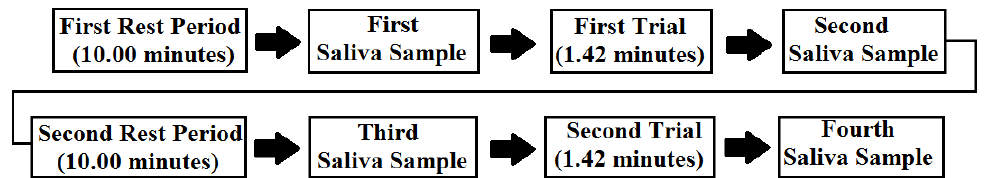
Figure 1. Conceptual diagram of the experiment’s design in which every participant took part in two consecutive